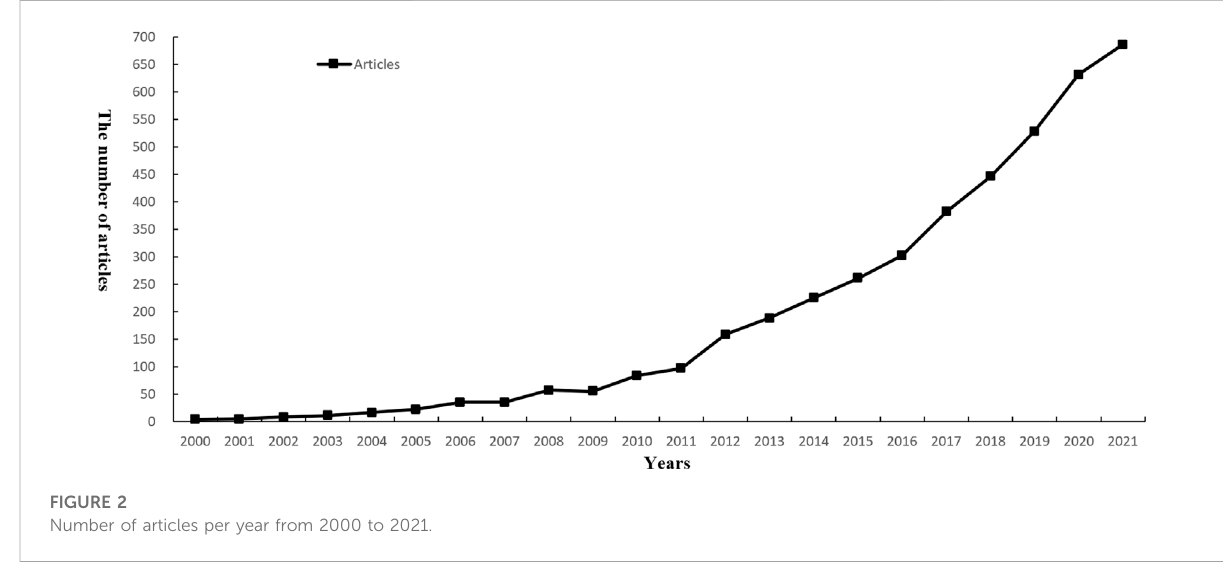
FIGURE 2 Number of articles per year from 2000 to 2021.